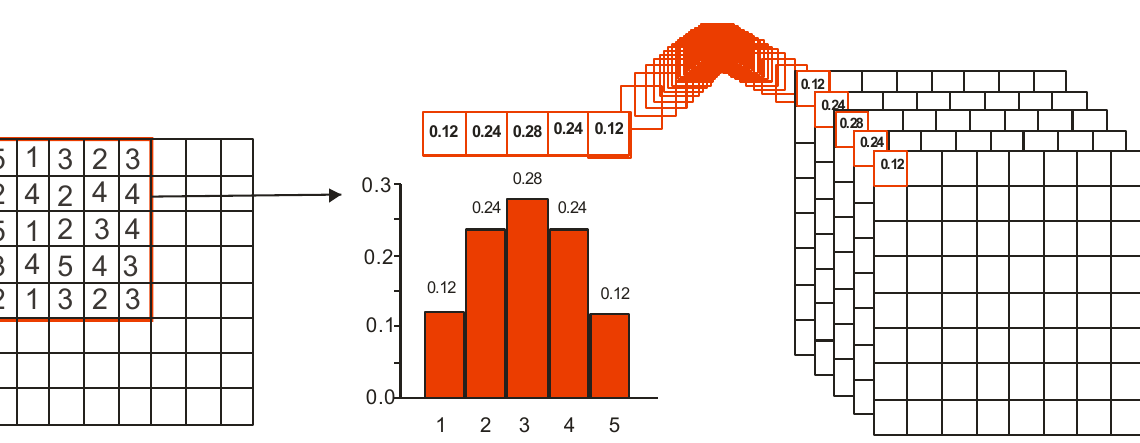
Figure 2. Procedures to generate the Probability Density Components: establishment of a moving window (for example, with a dimension of 5 × 5), calculating the frequency histogram, and the establishment of images of the probability density